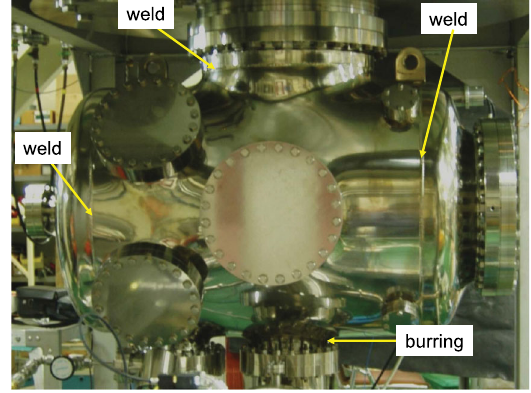
FIG. 13. Photograph of the gun vacuum